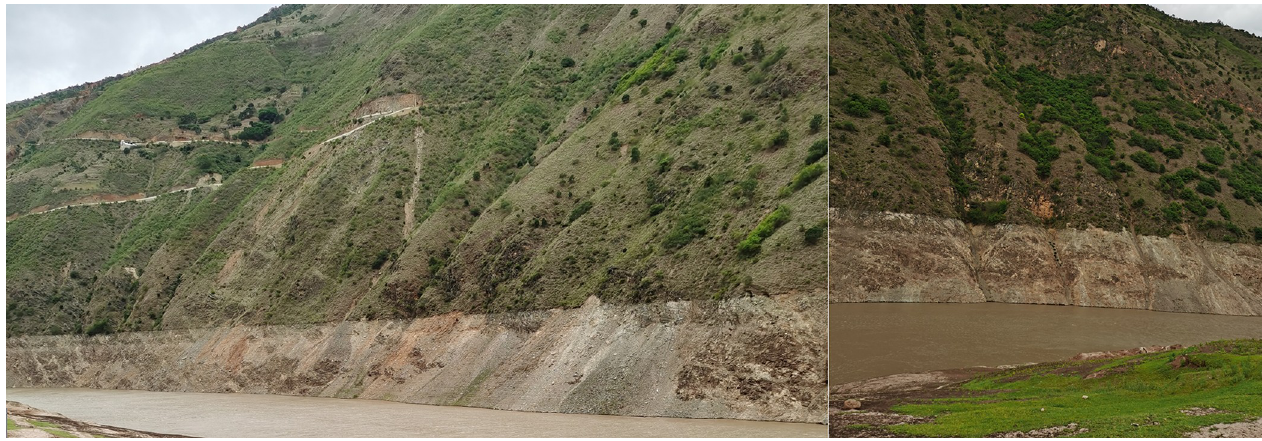
Fig 9. Steep-slope WLFZs of Lantsang